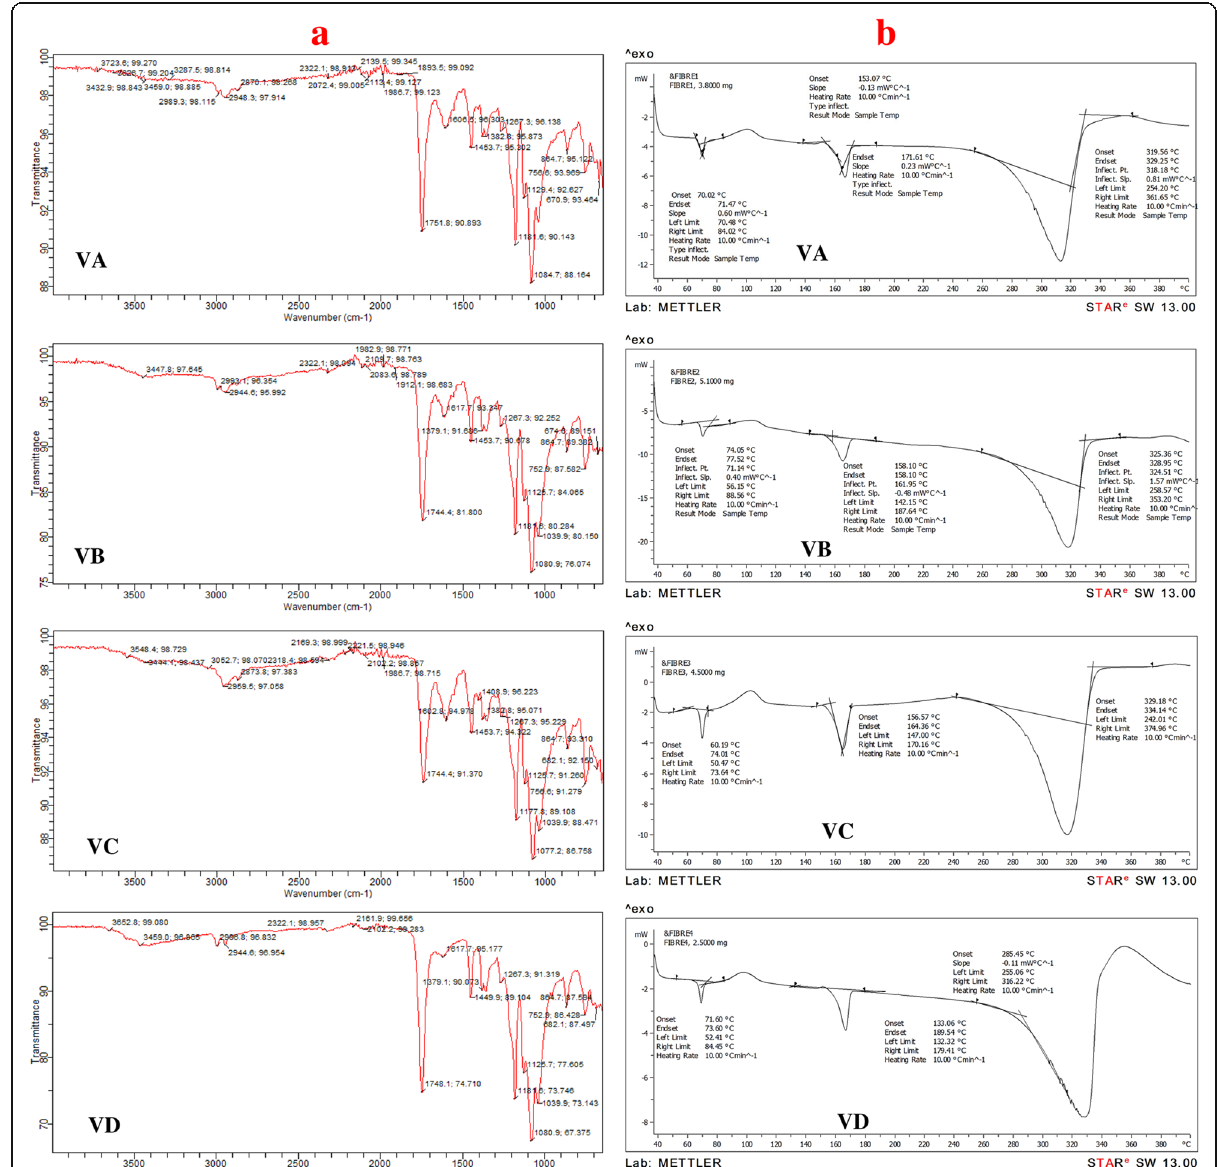
Fig. 3 (a)FTIR spectra of PLA/HA-valsartan hydrogel scaffolds VA, VB, VC, and VD. (b) DSC scans of PLA/HA-valsartan hydrogel scaffolds VA, VB, VC, and